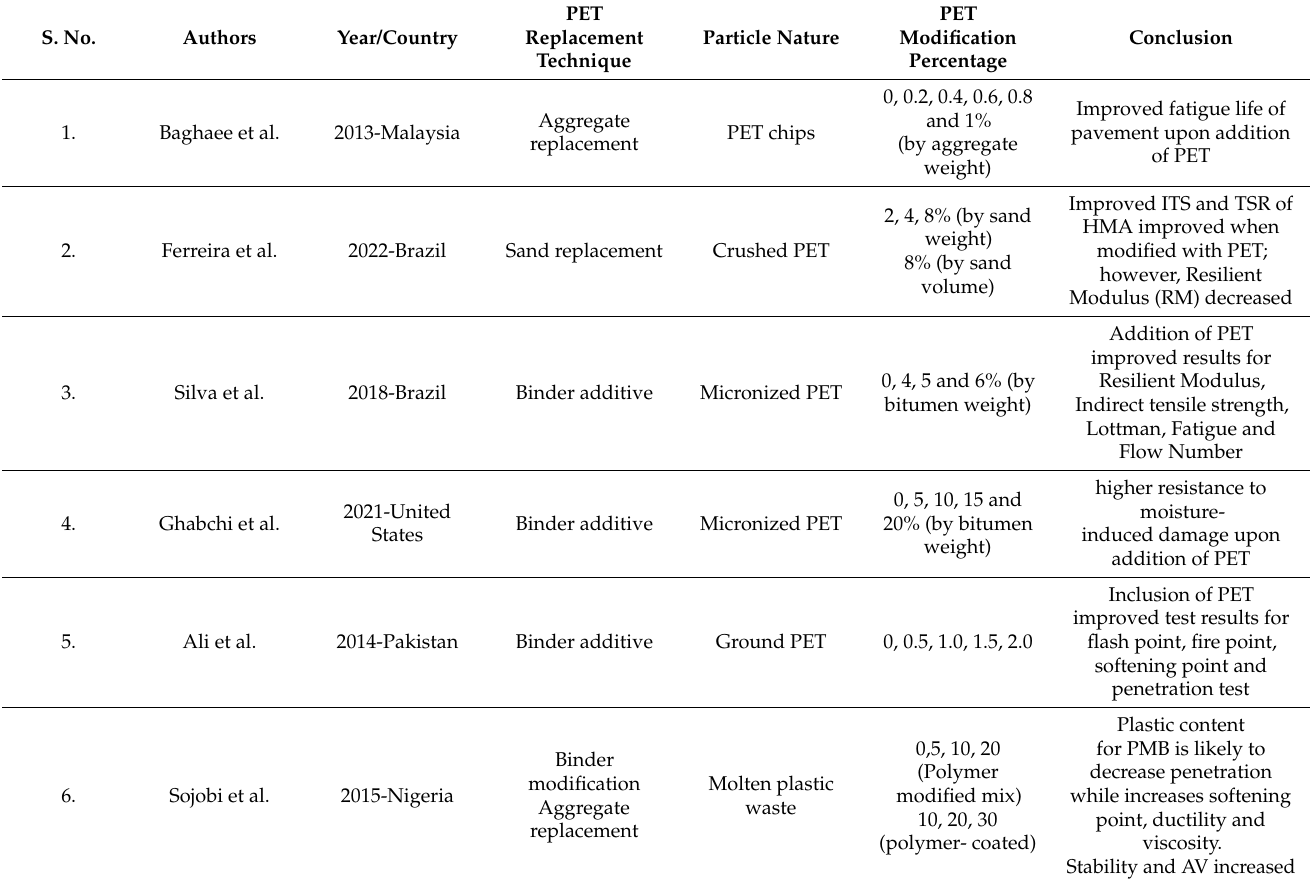
Table 1. Past studies incorporating PET in asphalt